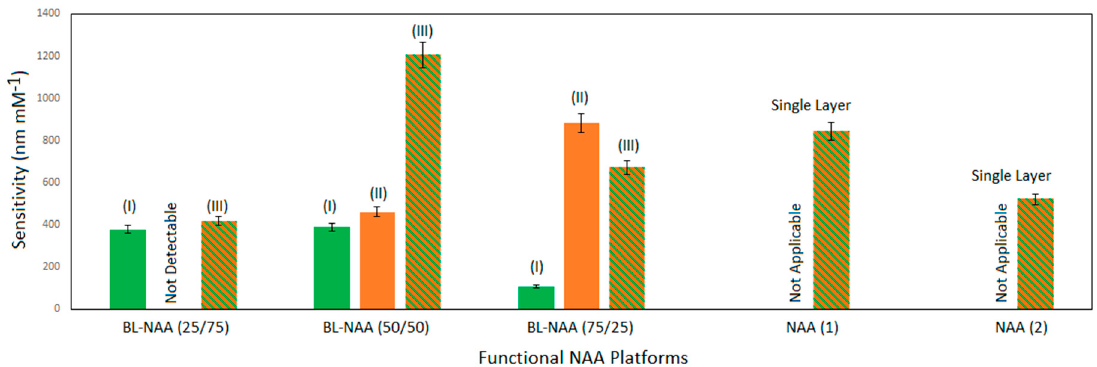
Figure 9. Bar chart summarizing the sensitivities (i.e., the slope of linear fittings shown in Figures 5–8) for BL-NAAs and NAAs sensing platforms modified with HSA-quercetin.